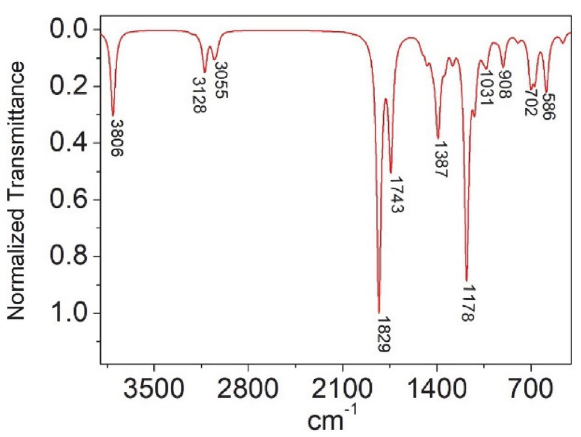
Figure 4: CAM-B3LYP/6-311++G(d,p) used to calculate FT-IR spectrum of C 5 H 8 O 2.